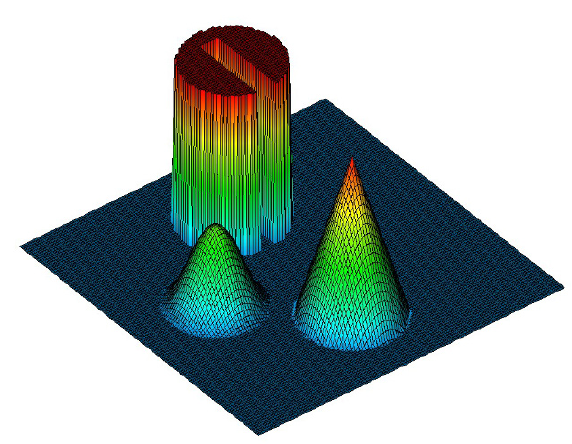
Figure 1. Initial data / exact solution at the final time t